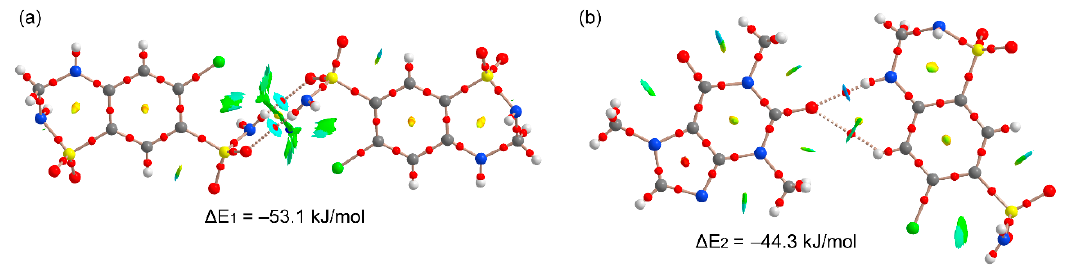
Figure 10. Combined QTAIM / NCIplot analysis of the H-bonded HCT ··· HCT homodimer ( a ) and CAF ··· HCT heterodimer ( b ) extracted from the solid-state X-ray structure of compound HCT–CAF.